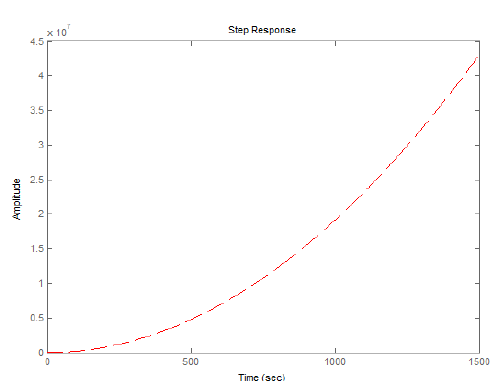
Figure 7. Step Response for the Open Form Figure 4 impulse response for the closed form (the signal is highlighted in green) is better than the open form (the signal is highlighted in green in Figure 5. In the early stage the fluctuation of this signal is not stable and it fluctuates around the position at zero. The value of the amplitude of the closed form in this case is zero at the latter half of the operating cycle (5*10 4 s) and the closed form reaches a steady state. For LQG regulator, the closed form responds well. The value of the amplitude of the open form in this case is large and the open form does not reach a steady state.